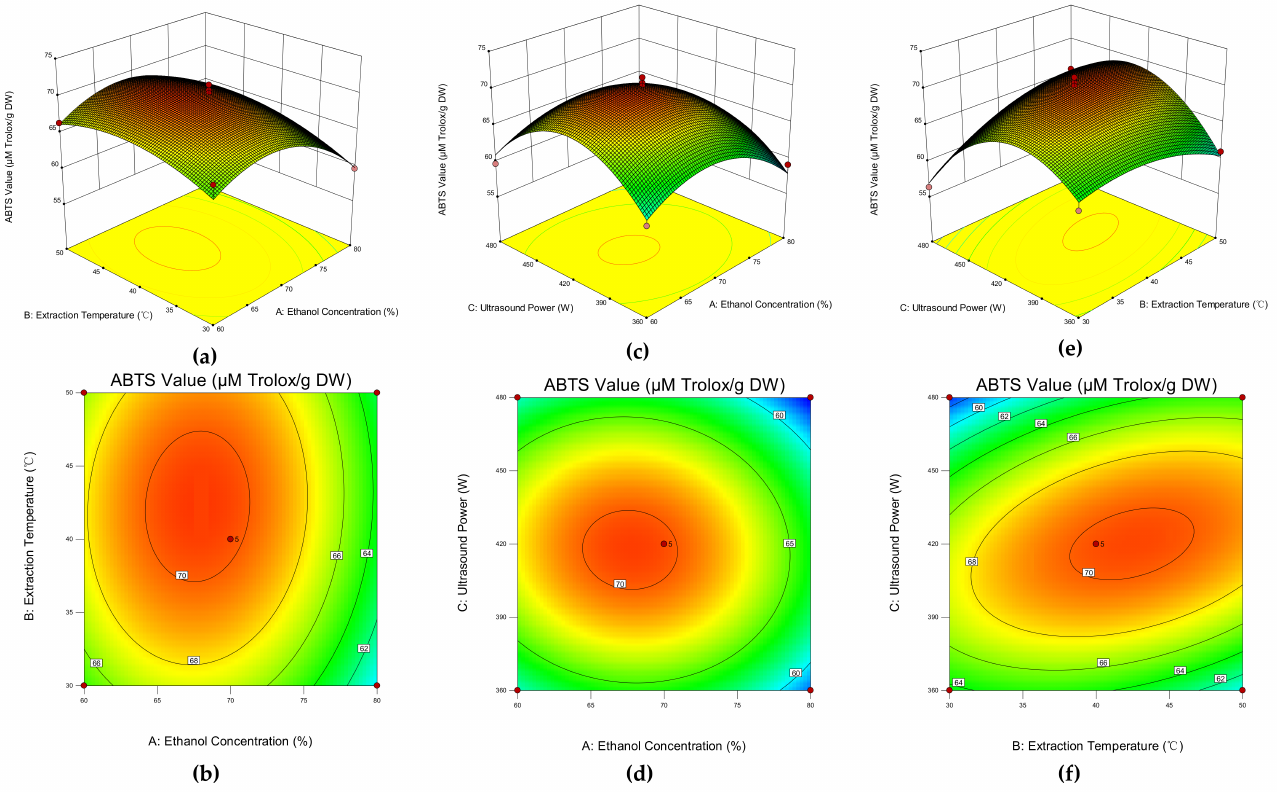
Figure 2. Response surface analysis of different interactions between ethanol concentration and extraction temperature ( a , b ); ethanol concentration and ultrasound power ( c , d ); and extraction temperature and ultrasound power ( e , f